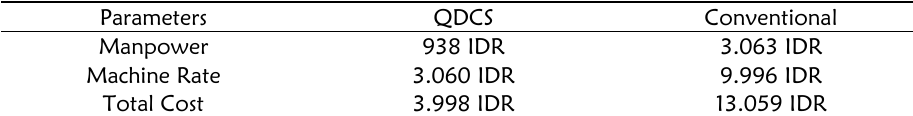
Table 3: Cost efficiencies